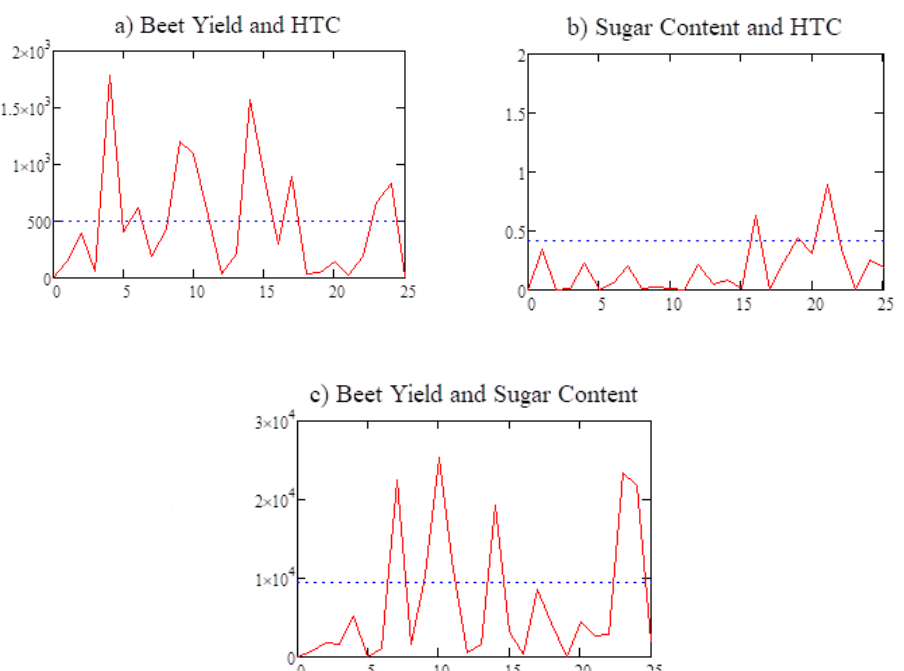
Figure 8. As in Figure 7, except for the cross-spectral analysis for ( a ) sugar beet yield (tons ha − 1 ) and HTC (mm ◦ C − 1 ), ( b ) sugar content (%) versus HTC(mm ◦ C − 1 ), and ( c ) sugar beet yield (tons ha − 1 ) versus sugar content (%). The units for the ordinate in each are the product of the two wave series squared Also, only the white noise line is shown here.